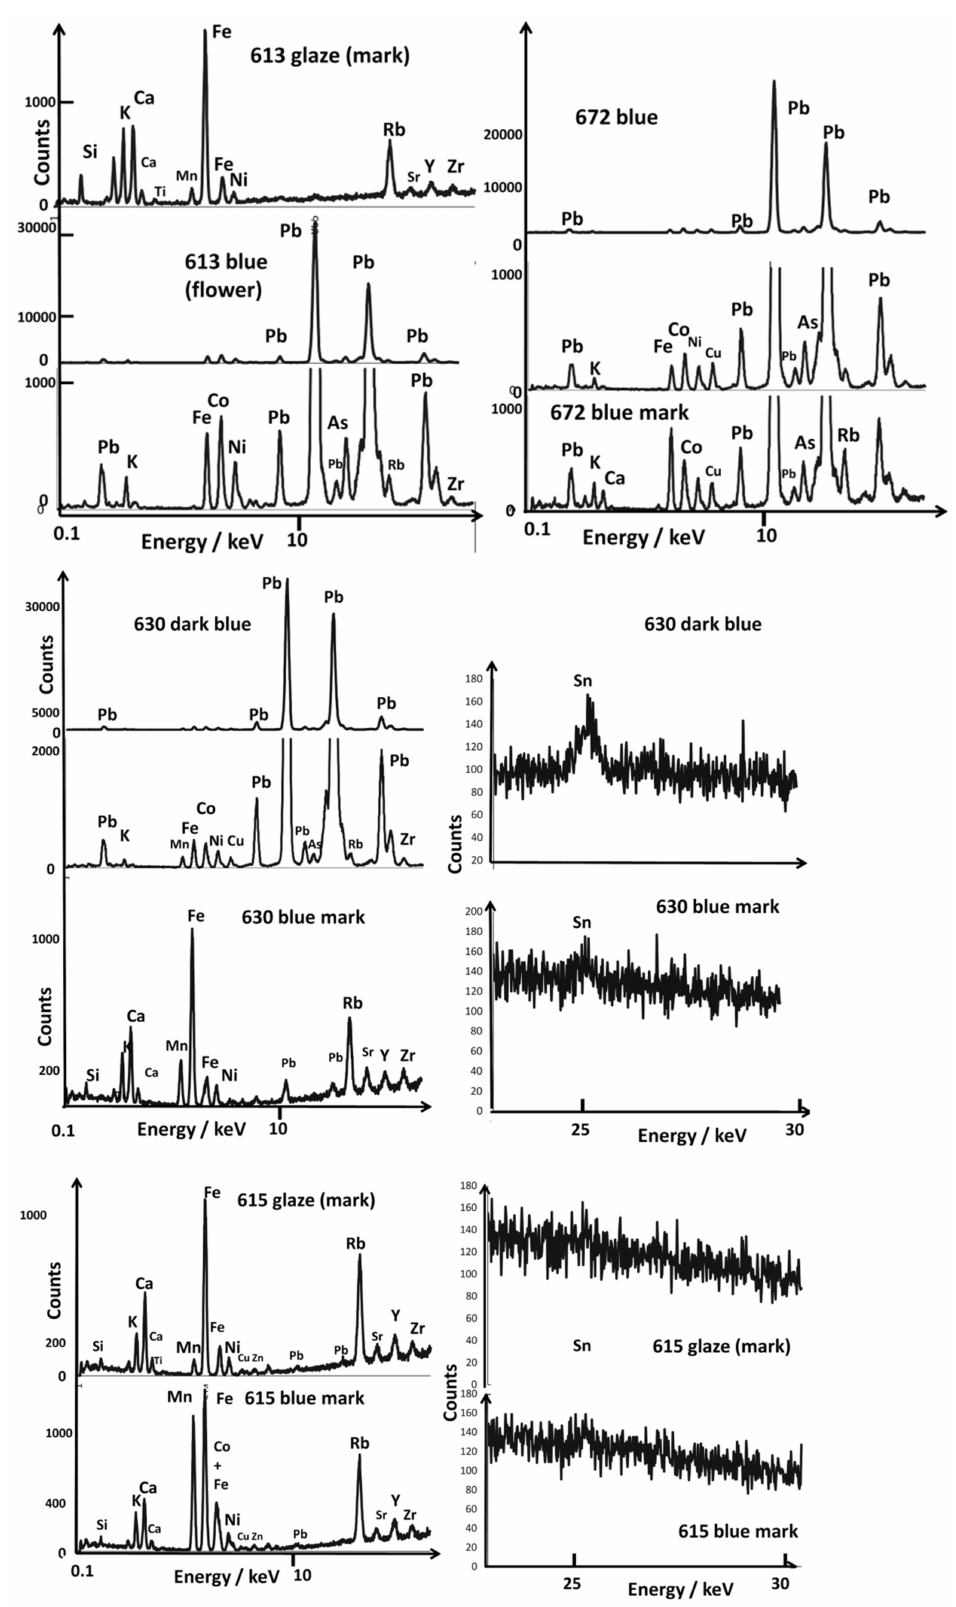
Figure 9. Comparison of representative XRF spectra for blue areas in the 0.1–20 and 20–30 keV energy ranges; for comparison, some spectra of paste and glaze coverage are also given; for comparison, glaze spectra are